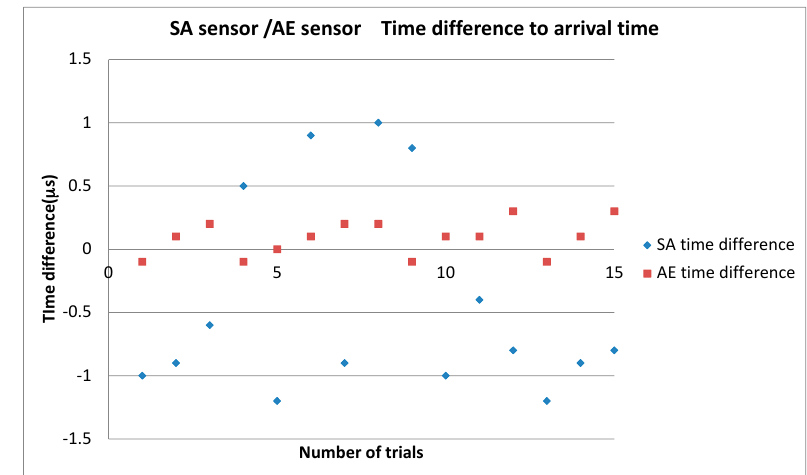
Figure 10. Time difference between each SA/AE sensor pair.